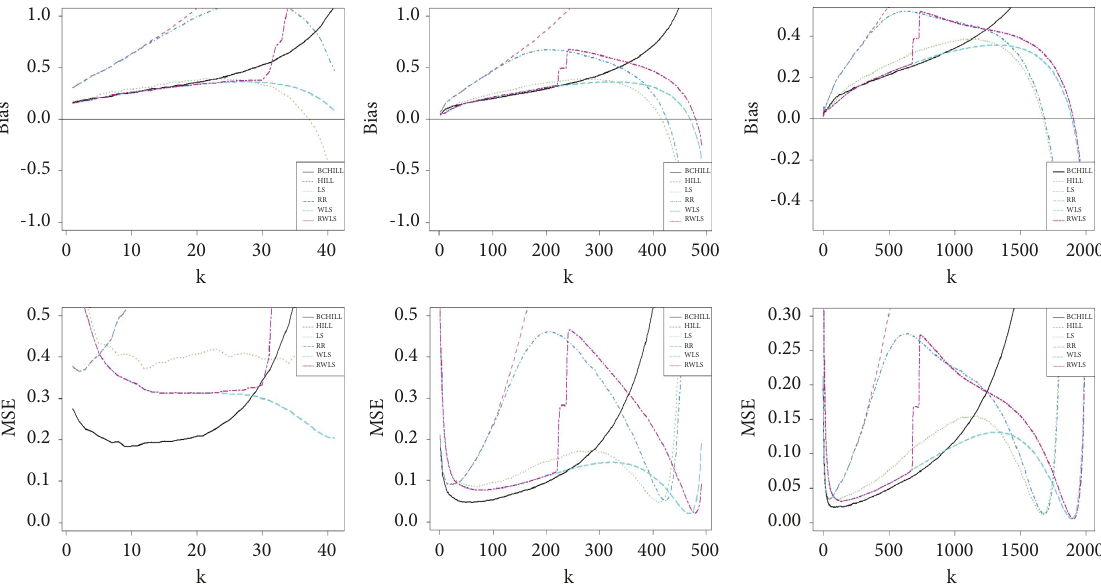
Figure 3: Results for Burr type XII distribution with c � 1 . 0: Bias (top row) and MSE (bottom row). First column: n � 50; second column: n � 500; and third column: n �